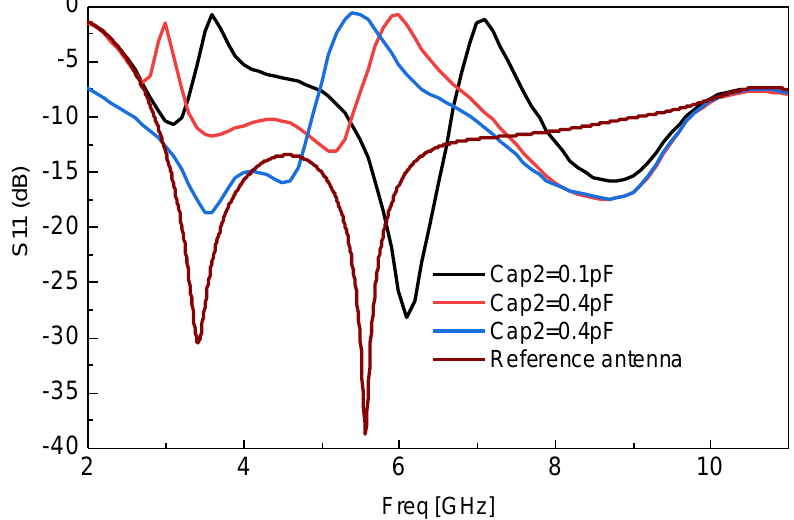
Figure 3. Switching between dual and single notched behavior by varying Cap2 only.